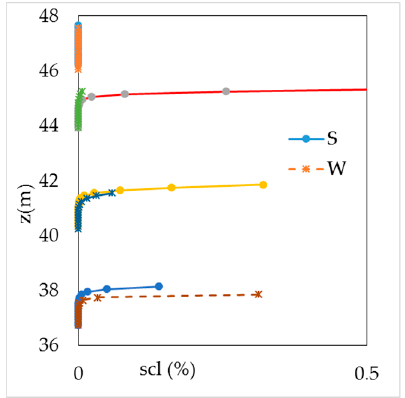
Figure 10. Void fraction in case of Z up = 52 m.